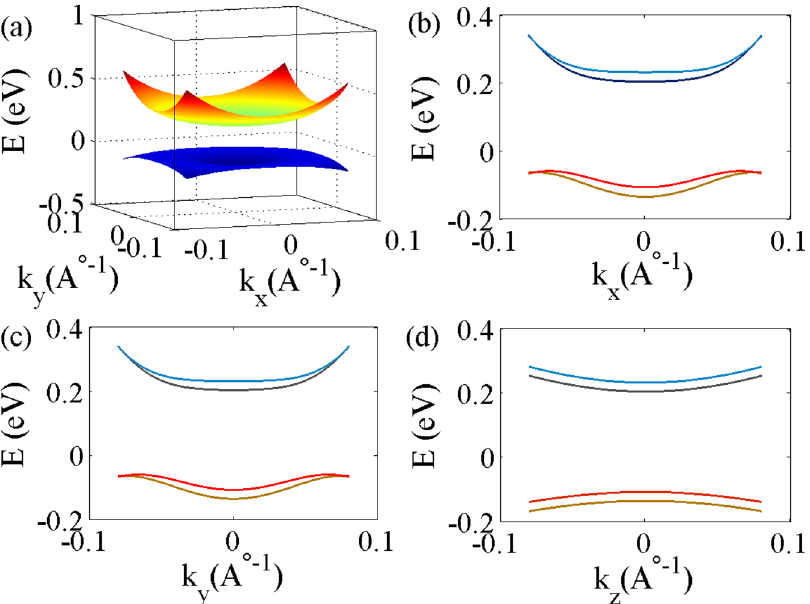
Figure 1. ( a ) 3D band dispersion of the four bands ( k z is suppressed) of 3D topological insulator (Bi 2 Se 3 ) near Γ point obtained by diagonalizing Hamiltonian described in Eq. (1). The doubly degenerate valence bands are separated from the doubly degenerate conduction bands by an energy equal to 0.3 eV. ( b – d ) depict the 2D band dispersions of the same four bands as mentioned above along k x , k y , and k z axis respectively in the presence of a Zeeman field of strength 5 T applied along the x direction. The Landé g-factors used here are g pv = g pc = 20 60